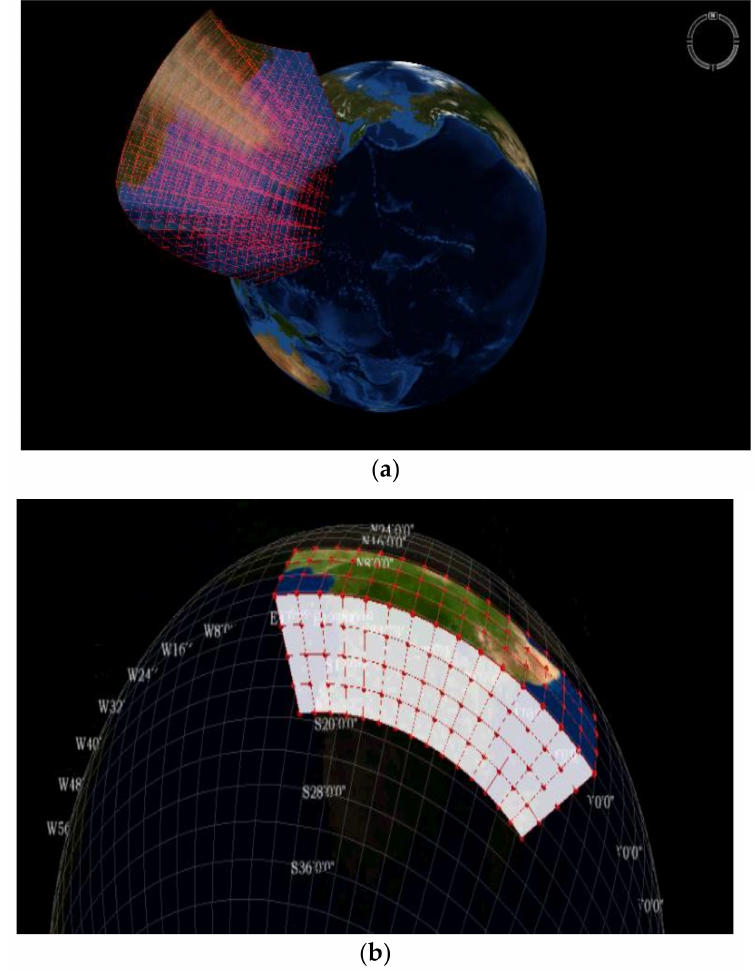
Figure 14. Experimental platform: ( a ) overground; ( b )